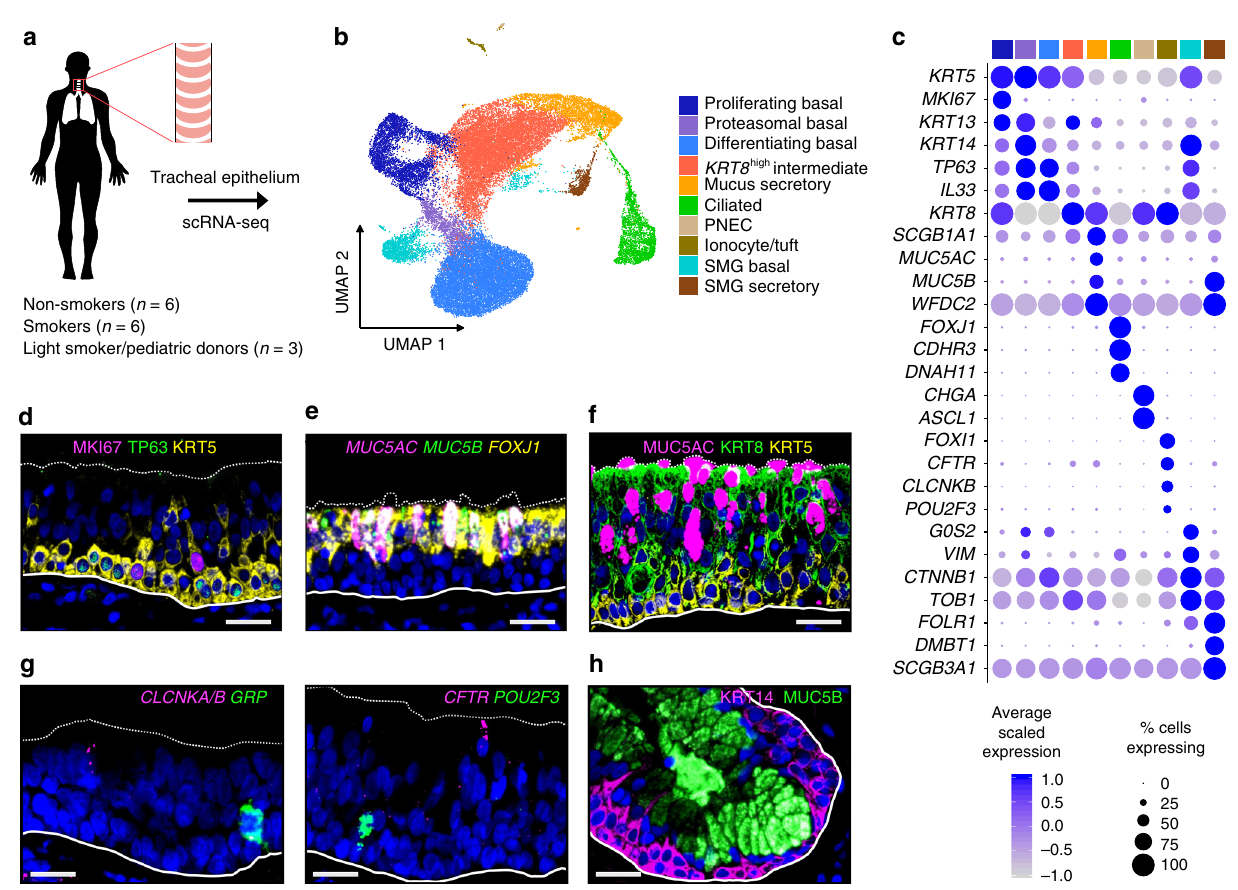
Fig. 1 Single-cell RNA-seq reveals broad cellular diversity within the human tracheal epithelium. a Study design for scRNA-seq of human tracheal epithelium. b UMAP visualization of cells in the human trachea depicts unsupervised clusters de fi ning broad cell types present. c Dot plot highlights markers distinguishing broad cell categories based on average expression level (color) and ubiquity (size). Colored bar corresponds to the cell types/states in b . d Immuno fl uorescence (IF) labeling of human tracheal sections shows MKI67 (magenta) and TP63 (green) in a subset of KRT5 high (yellow) basal cells. Scale bar = 25 μ m. DAPI labeling of nuclei (blue). Dashed and solid lines represent the apical edge and basement membrane of the epithelium, respectively. e Fluorescence in situ hybridization (FISH) co-localizes (seen as white) MUC5B (green) and MUC5AC (magenta) mRNA to non-ciliated cells. FOXJ1 (ciliated marker, yellow). Dashed, solid lines and scale bar as in d . f IF labeling localizes KRT8 (green) to mid-upper epithelium, MUC5AC (magenta), KRT5 (yellow). Dashed, solid lines, and scale bar as in d . g FISH distinguishes rare cell mRNA markers: left, PNECs ( GRP , green) and ionocytes ( CLCNKA/B , magenta); right, ionocytes ( CFTR , magenta) and tuft-like cells ( POU2F3 , green). Dashed, solid lines, and scale bars as in d . h IF labeling localizes MUC5B (green) and KRT14 (magenta) to distinct cells in the SMGs. Dashed, solid lines, and scale bar as in d . See also Supplementary Figs. 1 and